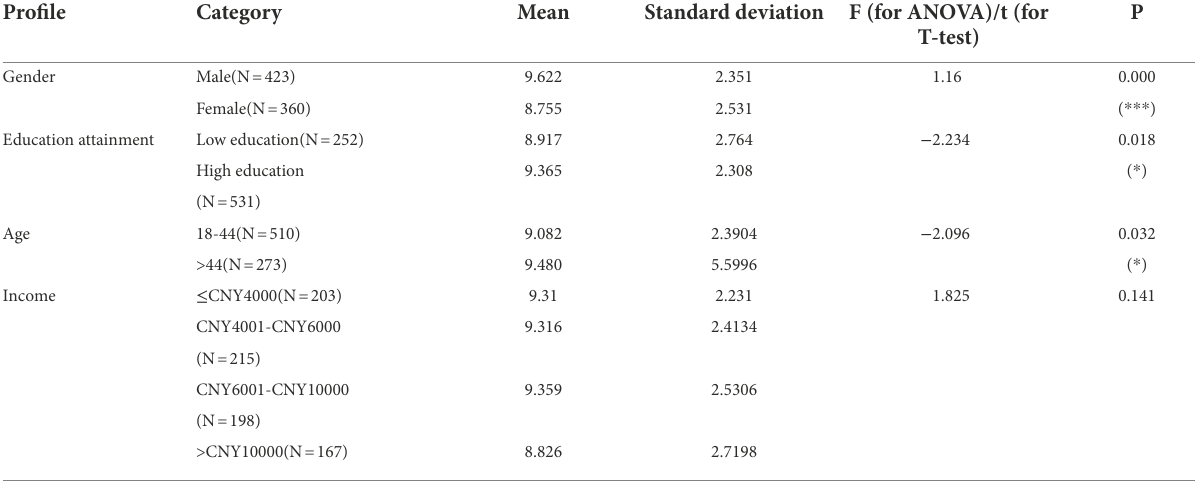
TABLE 6 Test results of the difference of demographic characteristics on public acceptance. (Low perceived stress group samples). Profile Category Mean Standard deviation F (for ANOVA)/t (for